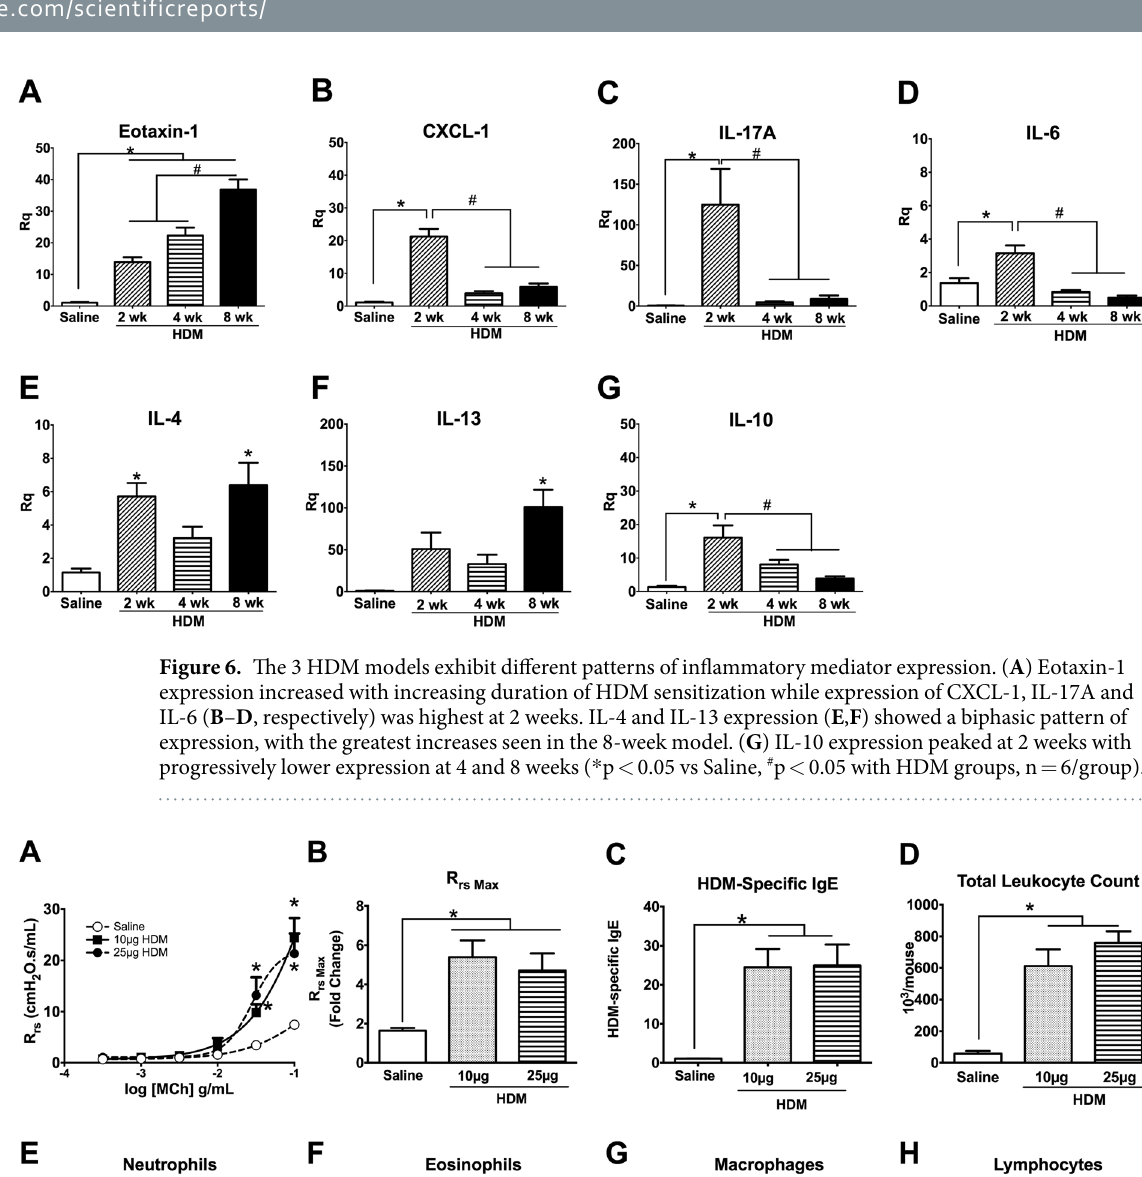
Discussion Reversible airflow obstruction, airways inflammation, AHR to contractile agonists (spasmogens, such as meth- acholine or histamine) and airway remodeling are defining features of asthma 7,10 . Airways inflammation and enhanced MCh-responsiveness are observed in virtually all experimental models of allergic airways inflammation currently used 12,17,20–23,25,26 , with varying degrees depending on the dose, frequency, duration and type of allergen